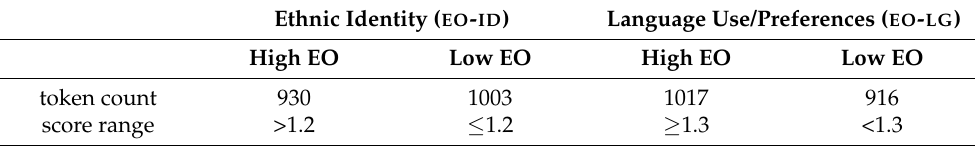
Table 3. Ethnic-orientation-based subgroups of heritage-speaker data compared (n =